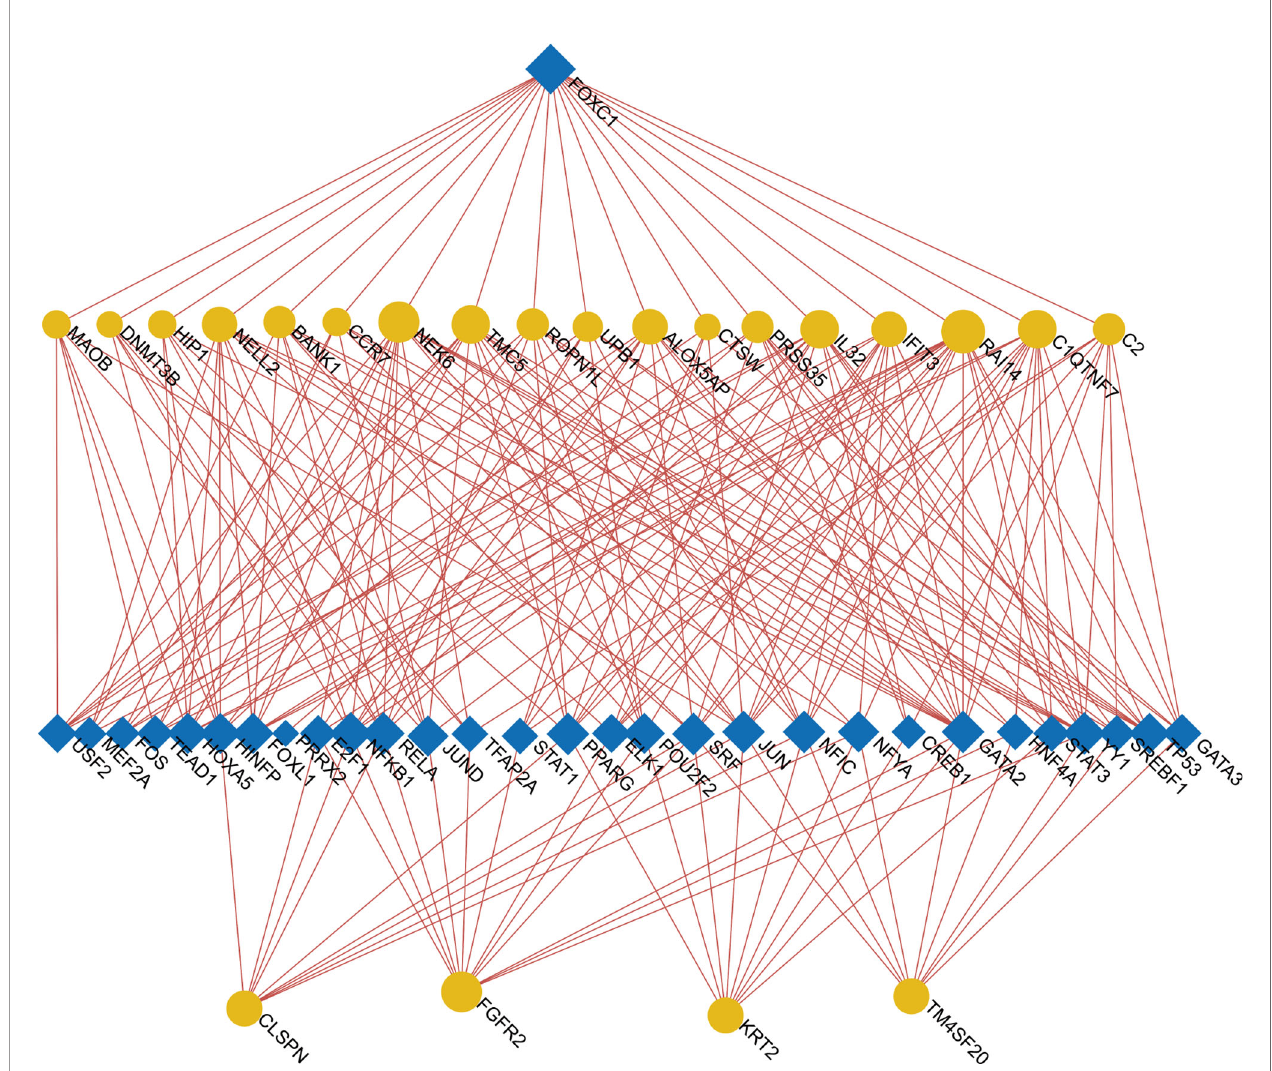
FIGURE 7 | The Network Analyst created an interconnected regulatory interaction network of DEG-TFs. In it, blue square nodes represent TFs, gene symbols interact with TFs as yellow circle